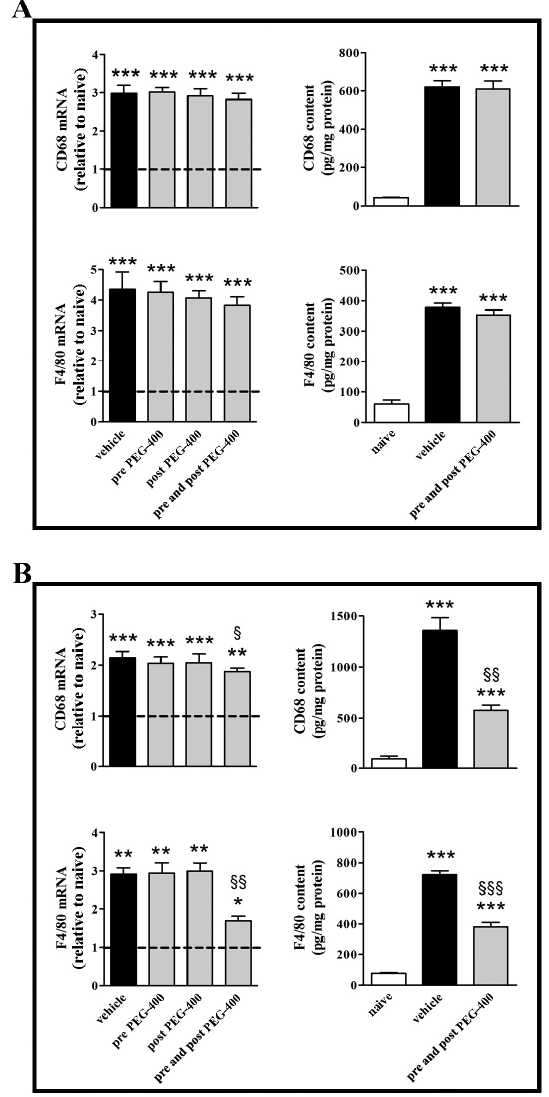
Figure 4. mFAG dietary supplementation reduces the PEG-400-induced upregulation of markers of macrophage infiltration in the retina ( A ) or in the RPE/choroid ( B ). Levels were evaluated in mice untreated or subretinally injected with 0.5 mg PEG-400 and receiving vehicle or mFAG for 10 days before PEG-400 injection (pre-PEG-400), for five days after PEG-400 injection (post-PEG-400), or for 10 days before and five days after PEG-400 injection (pre- and post-PEG-400). Transcripts were evaluated by relative quantification with qPCR. Data were analyzed by the formula 2 −ΔΔ CT using Rpl13a as the internal standard. Proteins were evaluated by ELISA. Data were presented as the mean ± S.E.M. ( n = 6/group). * p < 0.05, ** p < 0.01, and *** p < 0.001 versus naive; § p < 0.05, §§ p < 0.01, and §§§ p < 0.001 versus vehicle (one-way ANOVA followed by the Newman-Keuls multiple comparison post-hoc test). Dotted lines, mRNA levels in naive; white bars, naive; black bars, PEG-400-induced mice with vehicle dietary supplementation; grey bars, PEG-400-induced mice with mFAG dietary supplementation.